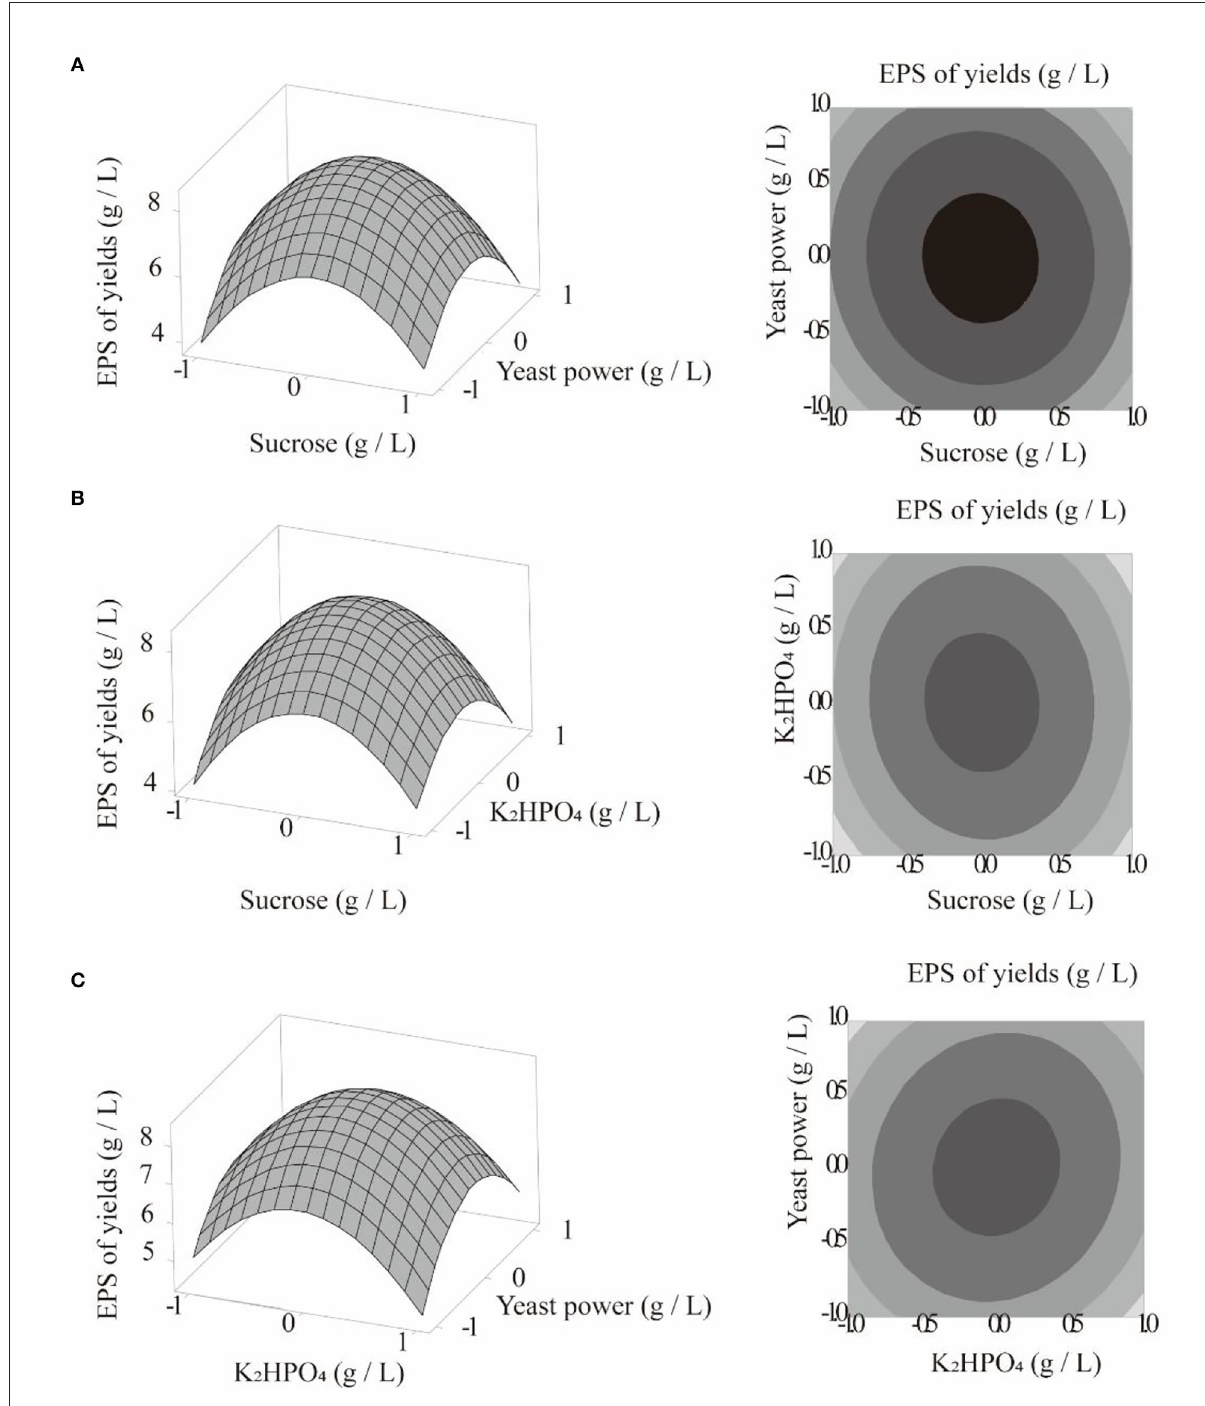
FIGURE4 Curved surface plot and curved graph: polysaccharide yield, sucrose, and yeast powder (A) ; polysaccharide yield, dipotassium hydrogen phosphate, and sucrose (B) ; polysaccharide yield, dipotassium hydrogen phosphate, and yeast powder (C) .